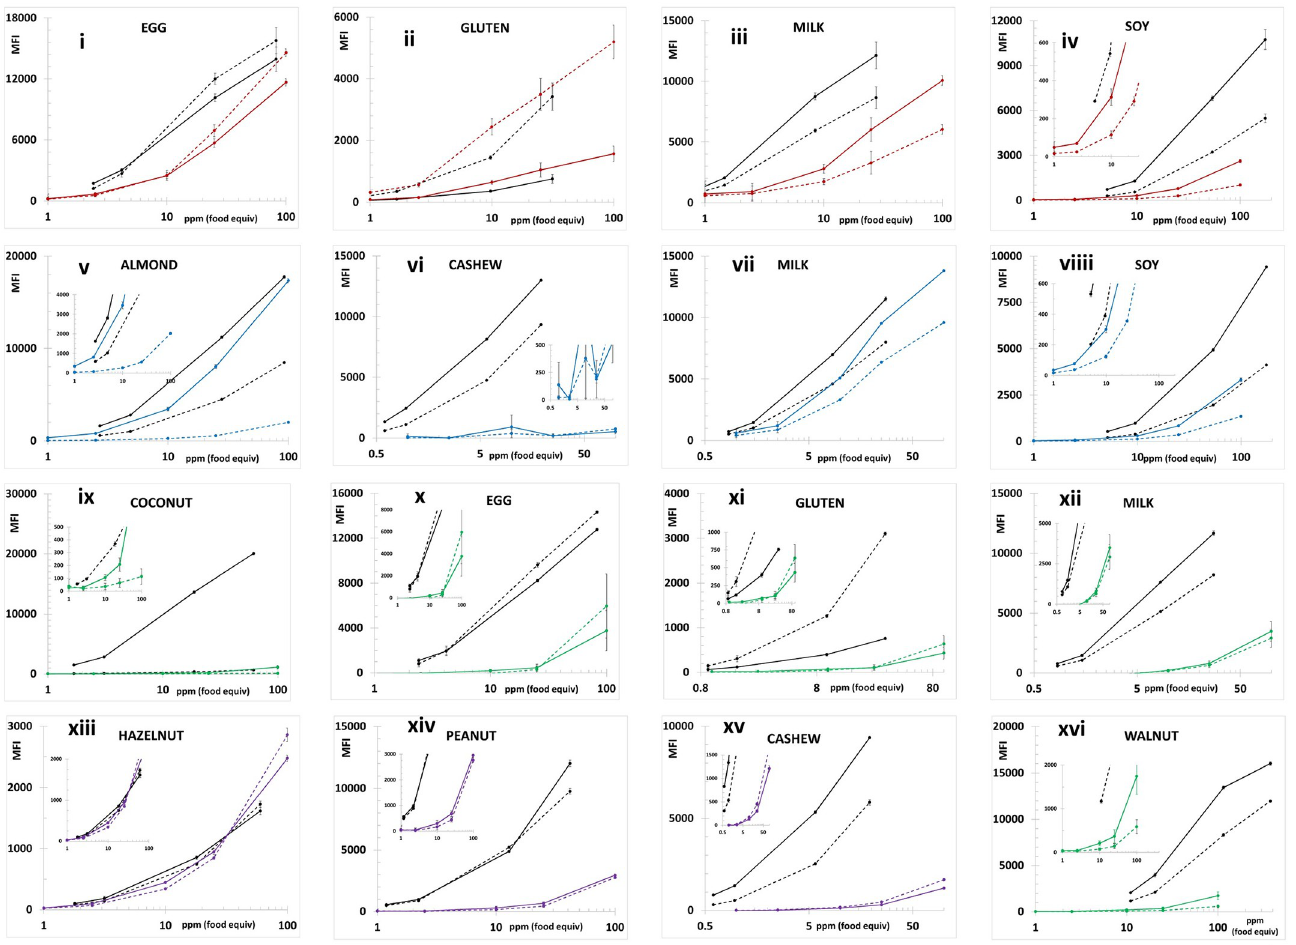
Fig 6. Average MFI of bead sets generating MFI with incurred food samples by Lab 03. Same as Fig 4 except the average of only the triplicate analyses generated by Lab 03.